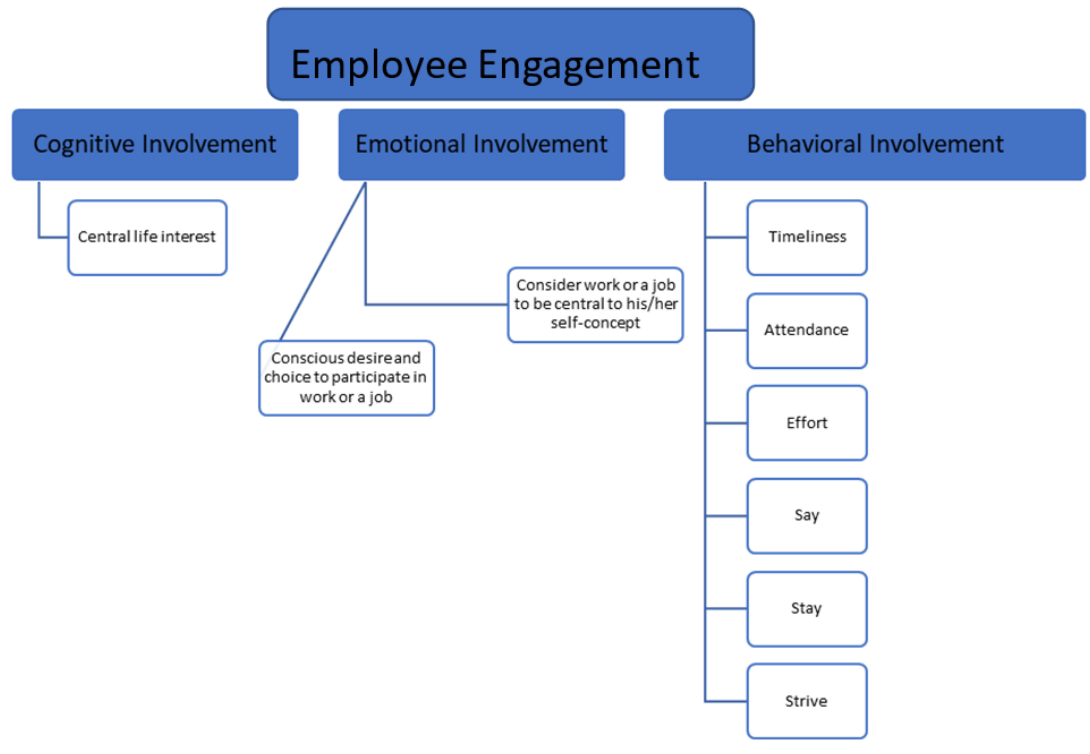
Figure A1. Source: Iddagoda et al., (2016).